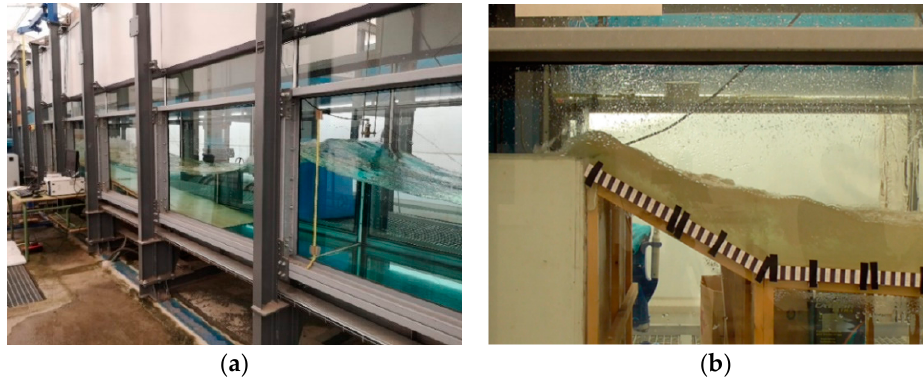
Figure 1. Tests set up: ( a ) wave generation area of the flume, and ( b ) overtopping event.